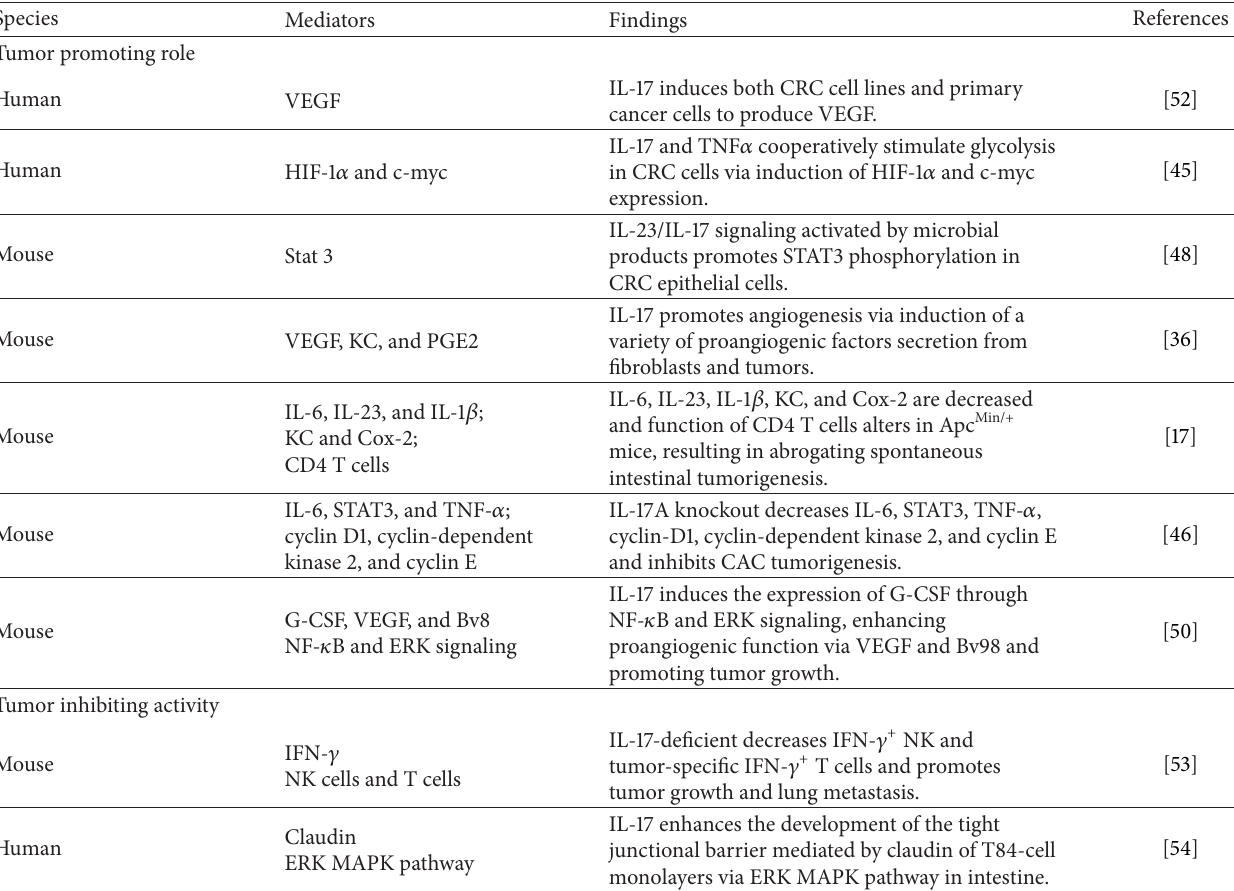
Table 1: Role of IL-17 in